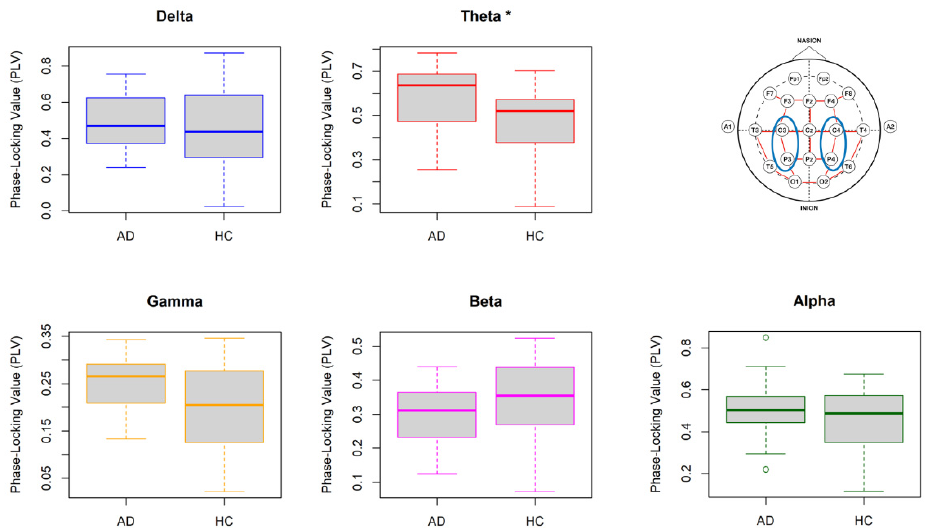
Figure 4. The PLVs obtained from the homotopic pair in the centro-parietal region (Pair A). Plots marked with * indicate a statistically significant difference ( p < 0.05) between AD patients and HCs.